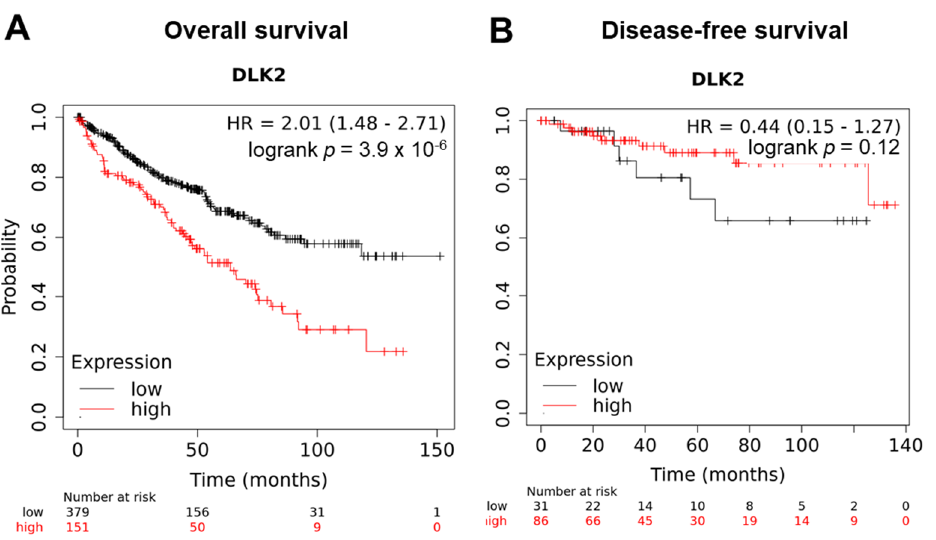
Figure 4. Tumoral DLK2 overexpression is associated with a poor survival outcome in ccRCC patients. The Kaplan–Meier analysis using KMplotter tool for ( A ) overall survival and ( B ) disease-free survival in ccRCC patients with a low or high DLK2 expression.